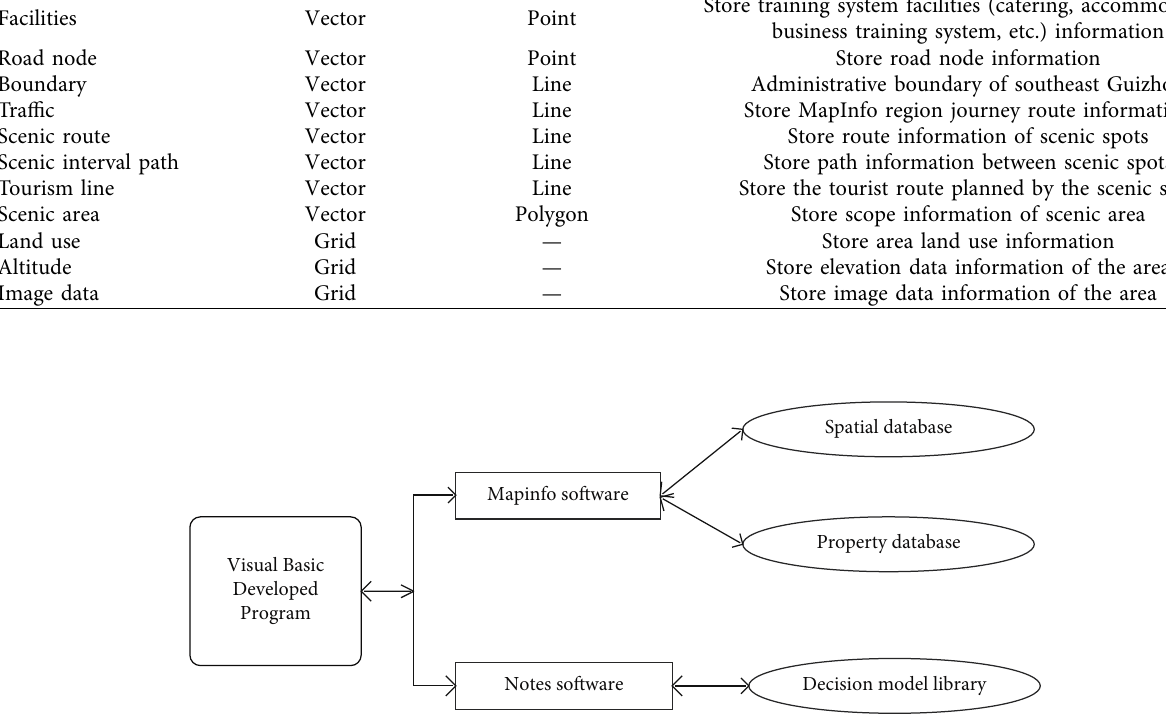
Figure 5: Software training system under database connection.